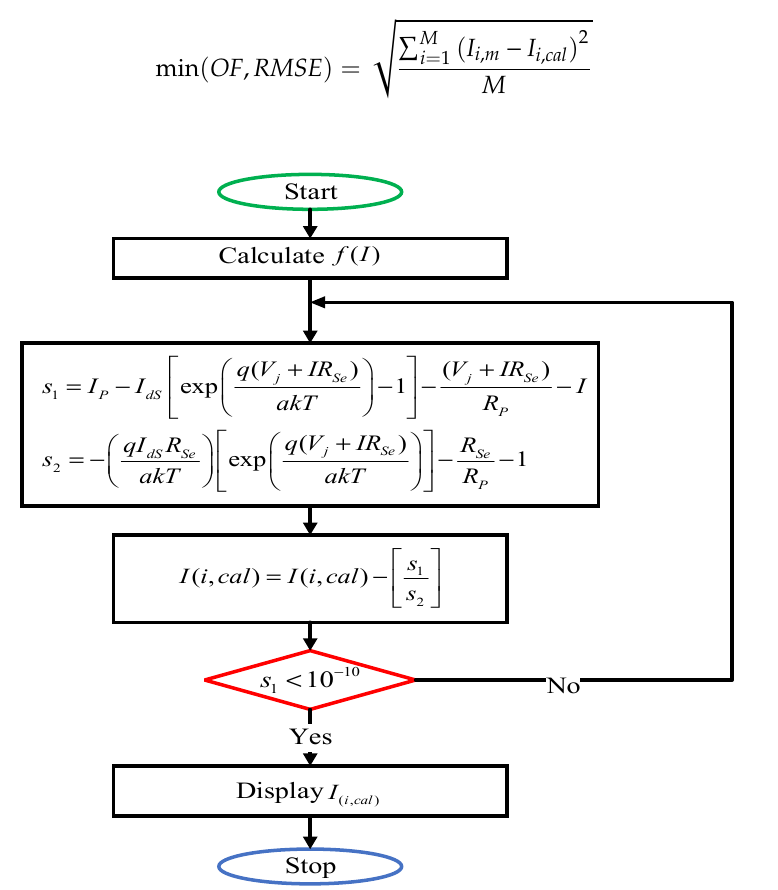
Figure 3. Newton–Raphson method (NRM) flow chart of the single-diode model for the current calculations.